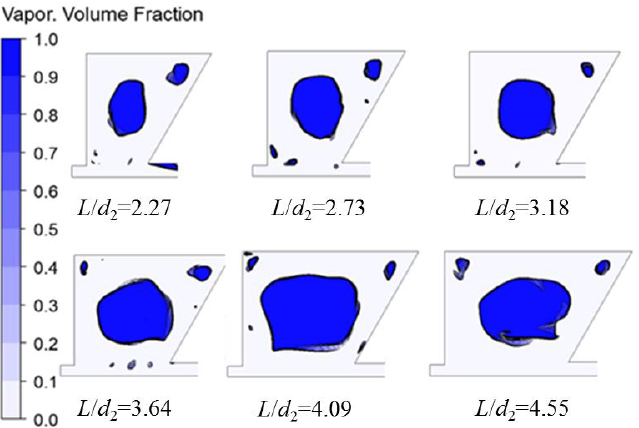
Figure 16. Curves of peak velocity and feedback velocity with cavity length.